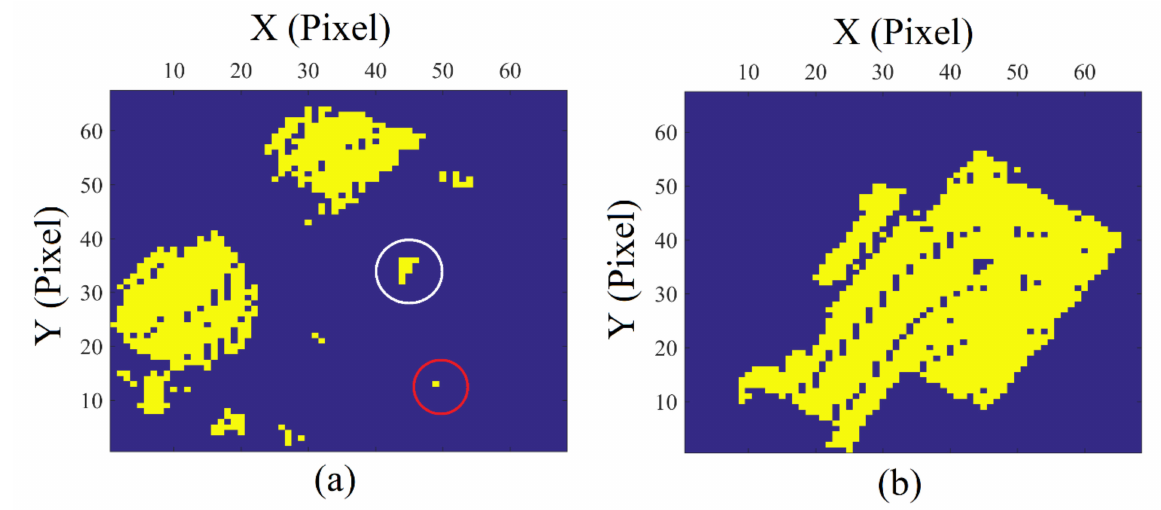
Figure 9. Visualization of normalized Digital Surface Models (nDSM) before improvement; ( a ) vegetation class; ( b ) roof class.